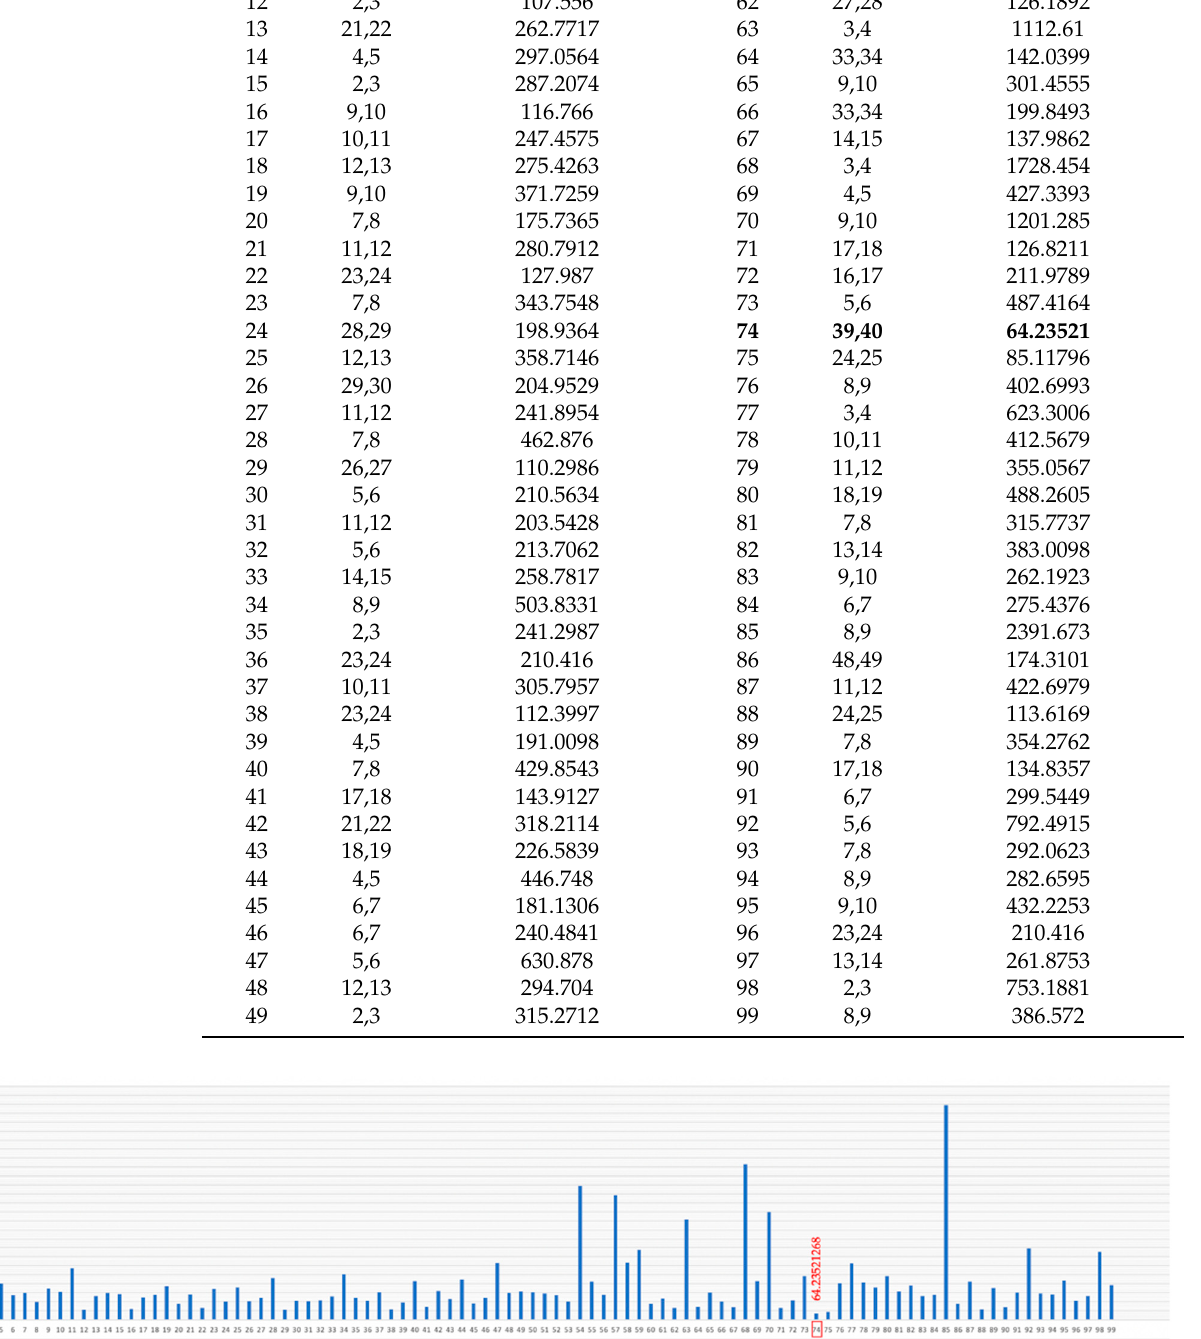
( a ) ( b ) Figure 9. ( a ) Sum of cumulative DTW distance value in sessions generated by the same user, user 74; ( b ) Sessions 39 (blue) and 40 (orange) of user 74. 4.2. Sessions Generated by Different User In the second stage of our ReMouse dataset study, the focus was on the pairwise analysis of sessions generated by different users. The findings of this analysis are summa- rized below: Observation 2.1 : Different users produced different-looking sessions when complet- ing the same/similar online task. The validity of this observation was confirmed by comparing all users’ sessions in our dataset (i.e., by calculating the cross-user pairwise minimum DTW distance). Table 3 shows the minimum normalized cumulative DTW distance value between two sessions of two distinct users out of all users’ sessions. As shown, the most similar trajectories gen- erated by two distinct users are sessions 6 and 29 of users 1 and 2, respectively. The actual DTW distance between these sessions is 21.94, which suggests that, although similar, these two sessions are not identical. This observation can be further generalized, implying that even though sessions generated by two distinct human users while completing the